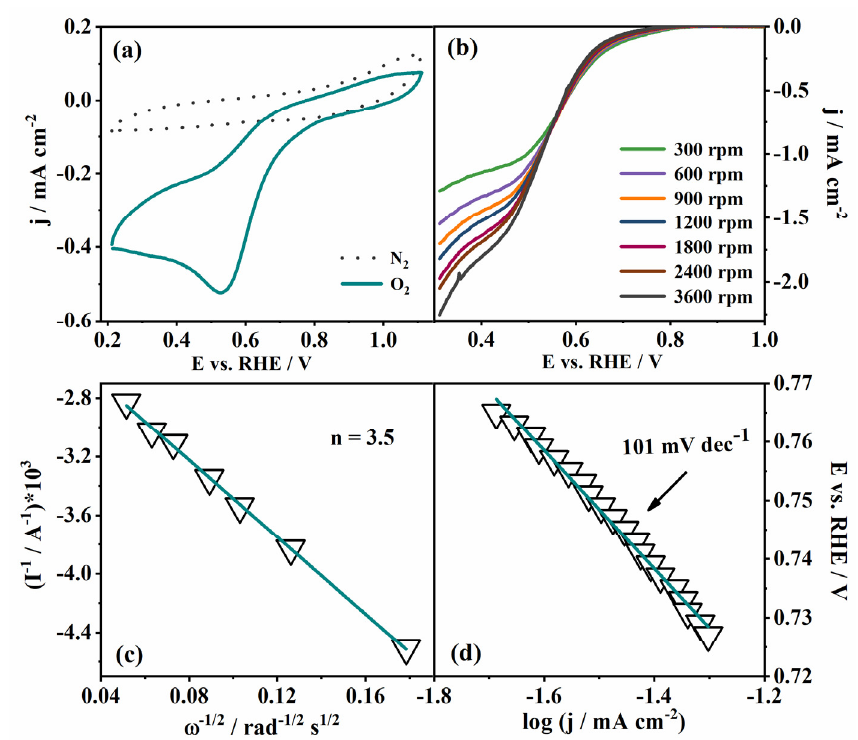
Figure 4. ( a ) CVs of Mn-CP in N 2 - and O 2 -saturated 0.1 M KOH, and ( b ) polarization curves at different rotation rates in O 2 -saturated 0.1 M KOH. ( c ) Koutecky–Levich analysis and ( d )